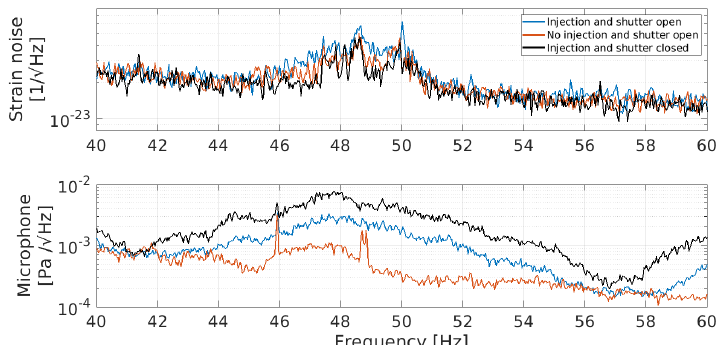
Figure 5. The amplitude spectral density of Hrec ( top ) and microphone ( bottom ) on the external squeezer bench, in reference condition (red) and when generating sound inside the room (blue), and then repeated after having blocked the beam onto the bench